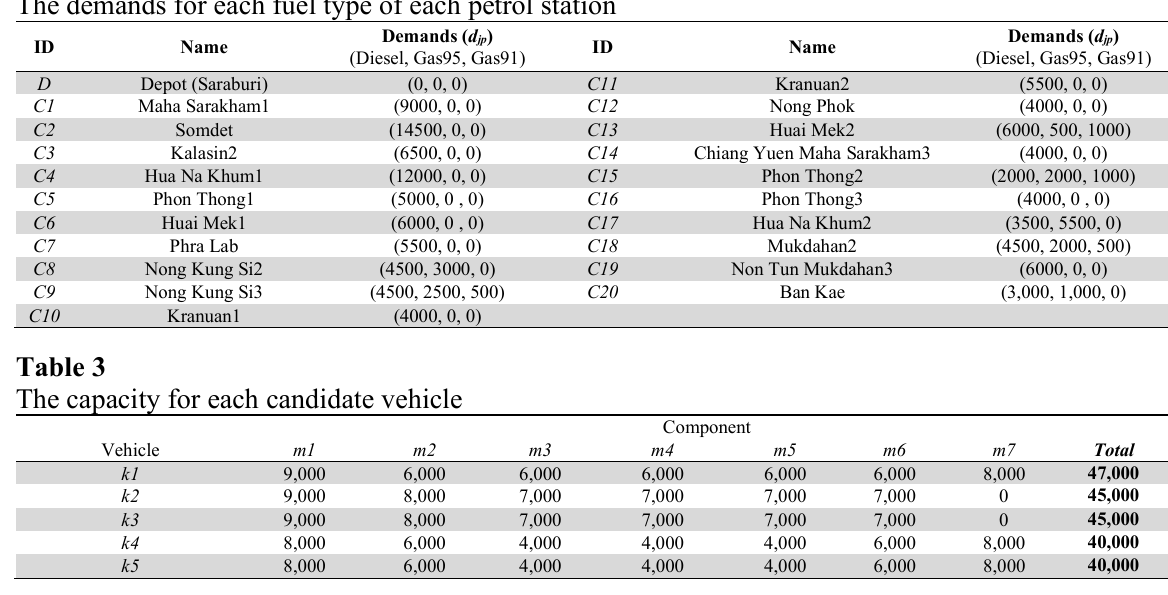
The demands for each fuel type of each petrol station